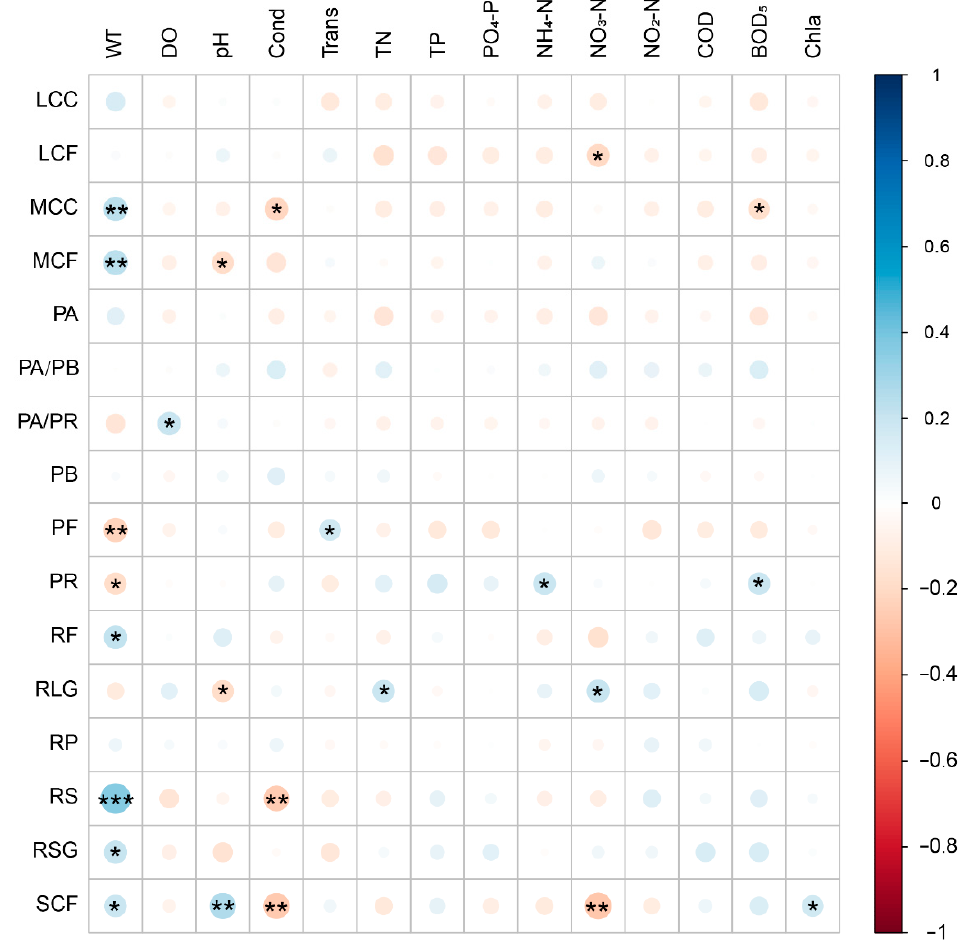
Figure 8. Bubble chart shows the Pearson correlation between zooplankton functional groups and environment factors. WT, water temperature; DO, dissolved oxygen; Cond, conductivity; Trans, transparency; TN, total nitrogen; TP, total nitrogen; COD, permanganate index; BOD 5 , biochemical oxygen demand after five days; Chla, chlorophyll a. * p < 0.05; ** p < 0.01; *** p < 0.001.